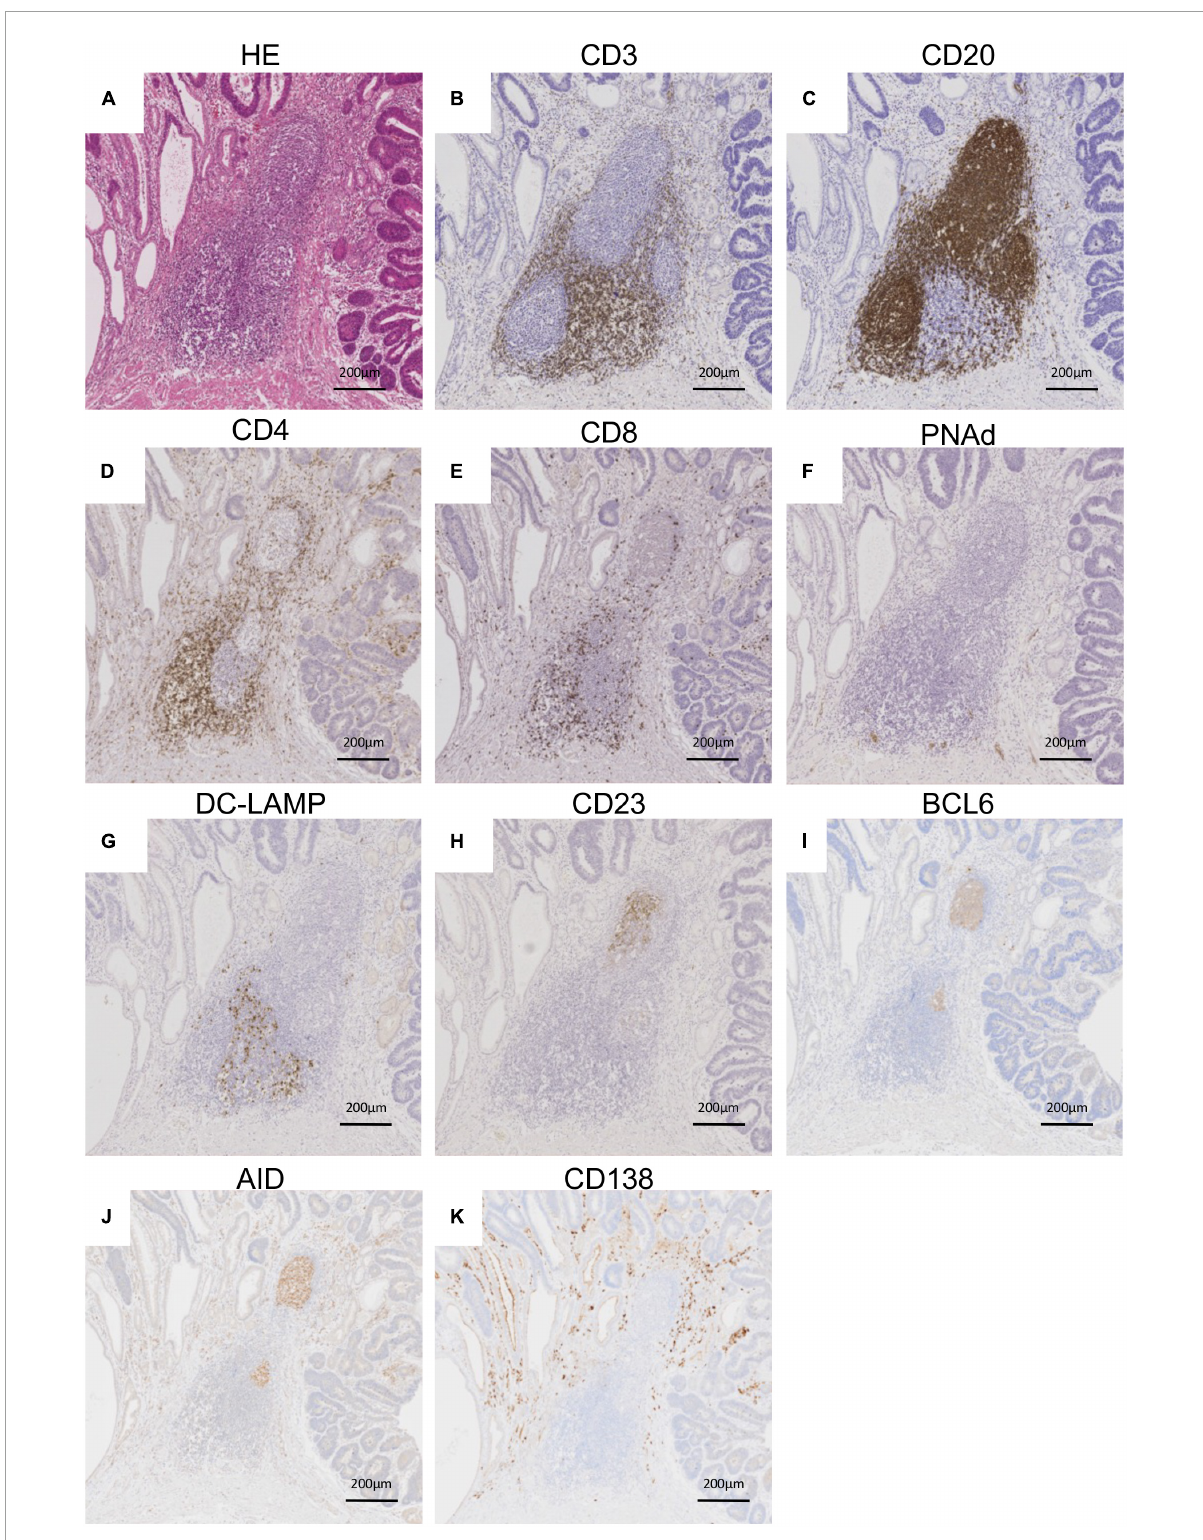
FIGURE2 Representative histological features of TLS. Serial sections of the stomach cancer tissue from a representative CAM patient (CAM #2) were subjected to HE staining (A) and immunohistochemical staining for CD3 (B) , CD20 (C) CD4 (D) , CD8 (E) , PNAd (F) , DC-LAMP (G) , CD23 (H) , BCL6 (I) , AID (J) , and CD138 (K) . Scale bar = 200 µ m. TLSs, tertiary lymphoid structures; HE, hematoxylin and eosin; PNAd, peripheral node addressin; DC-LAMP, dendritic cell lysosomal associated membrane glycoprotein; BCL6, B-cell lymphoma 6; AID, activation induced